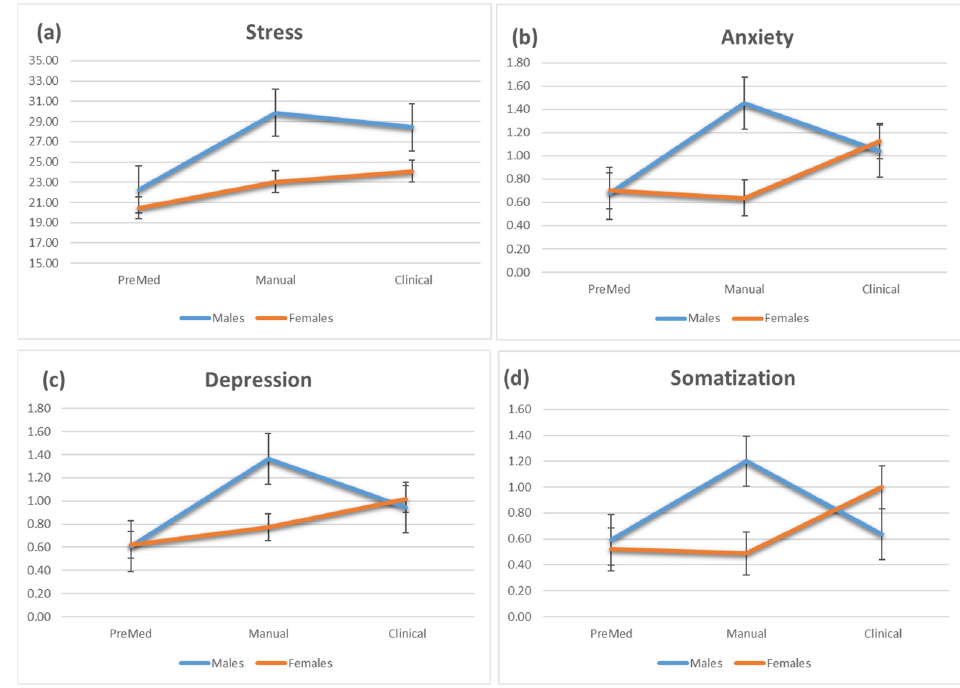
Figure 1. Emotional parameters according to the stage of study and sex: ( a ) Stress, ( b ) Anxiety, ( c ) Depression, and ( d ) Somatization.